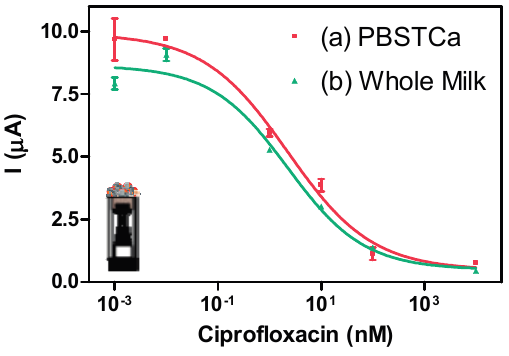
Figure 5. Calibration curves for ciprofloxacin with electrochemical readout using AMIS. ( a ) In PBST in red ( b ) In whole milk in green. Each point was the average of at least Ca three-well replicates, and the assays were run on two different days.